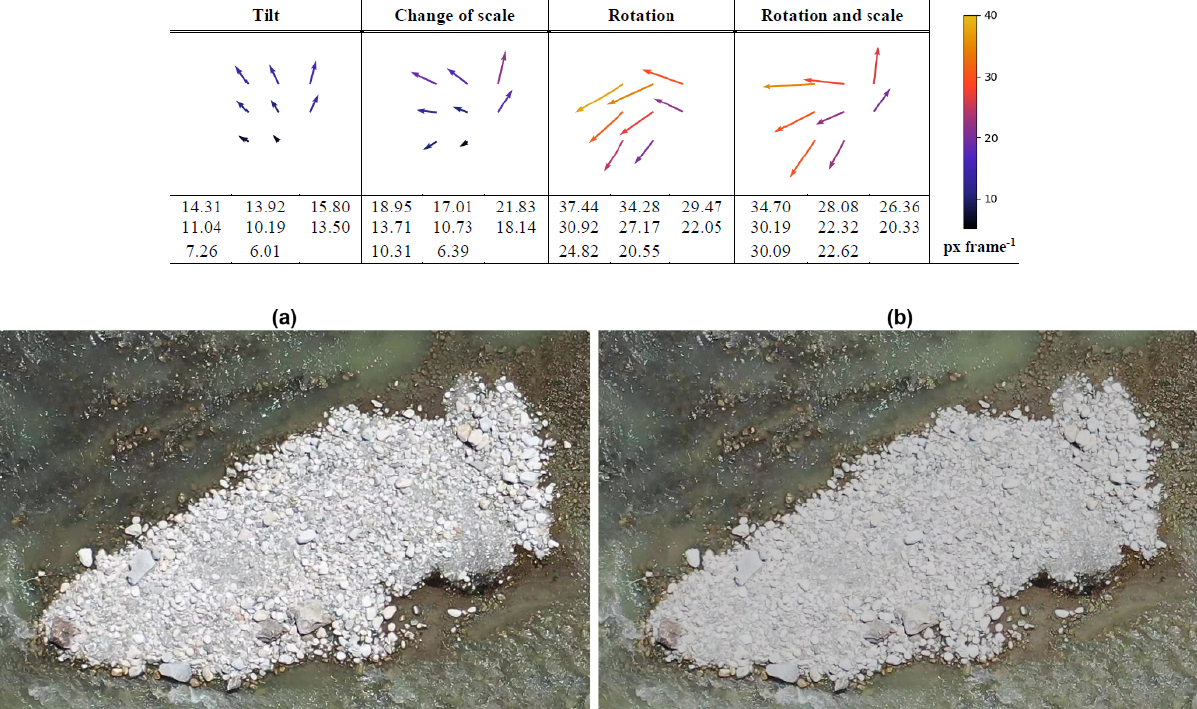
Figure 8. Alpine case study. (a) Original image section. (b) Image section after stabilisation with Blender/M, with noticeable changes in